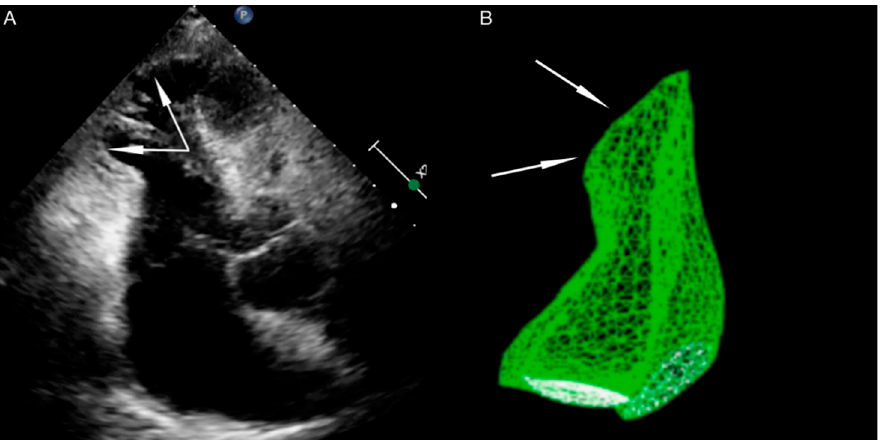
Figure 3. Echocardiography in a patient with right ventricle dysfunction (Authors’ own material). ( A ) 2D echocardiography, right ventricle view. ( B ) 3D echocardiography, right ventricle model. The arrows show the region of contractility disturbance.